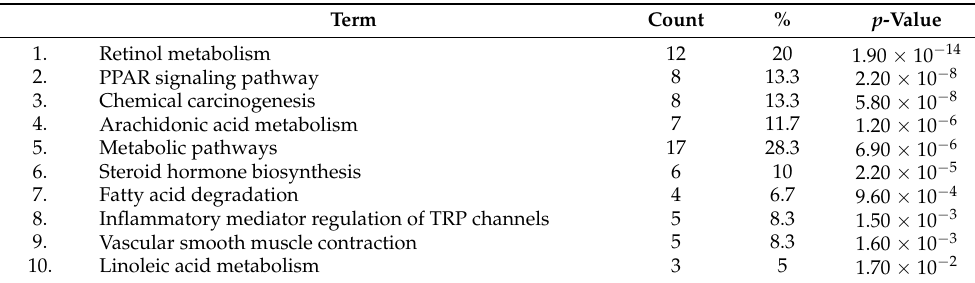
Table 5. KEGG signaling enrichment analysis between HFLPD-fed animals vs. HFD-fed animals by the DAVID Bioinformatics